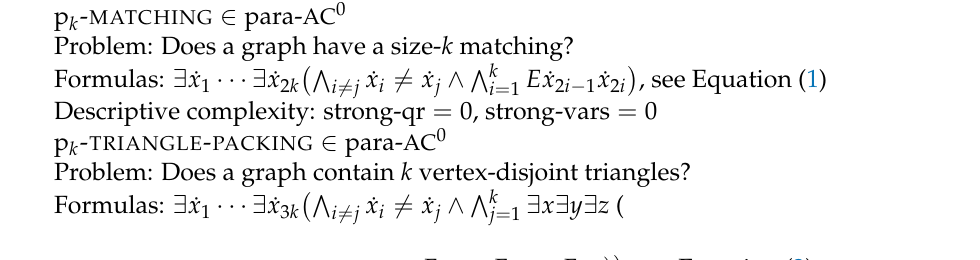
Table 1. Membership of the problems discussed in this paper in the two classes para-AC 0 and para-AC 0 ↑ and the formulas whose syntactic structures prove this. Except for clique problem, formulas exist where at least the number of strong variables is independent of the parameter— but it is not always the most “natural” formulas that have this desirable property, see the vertex cover